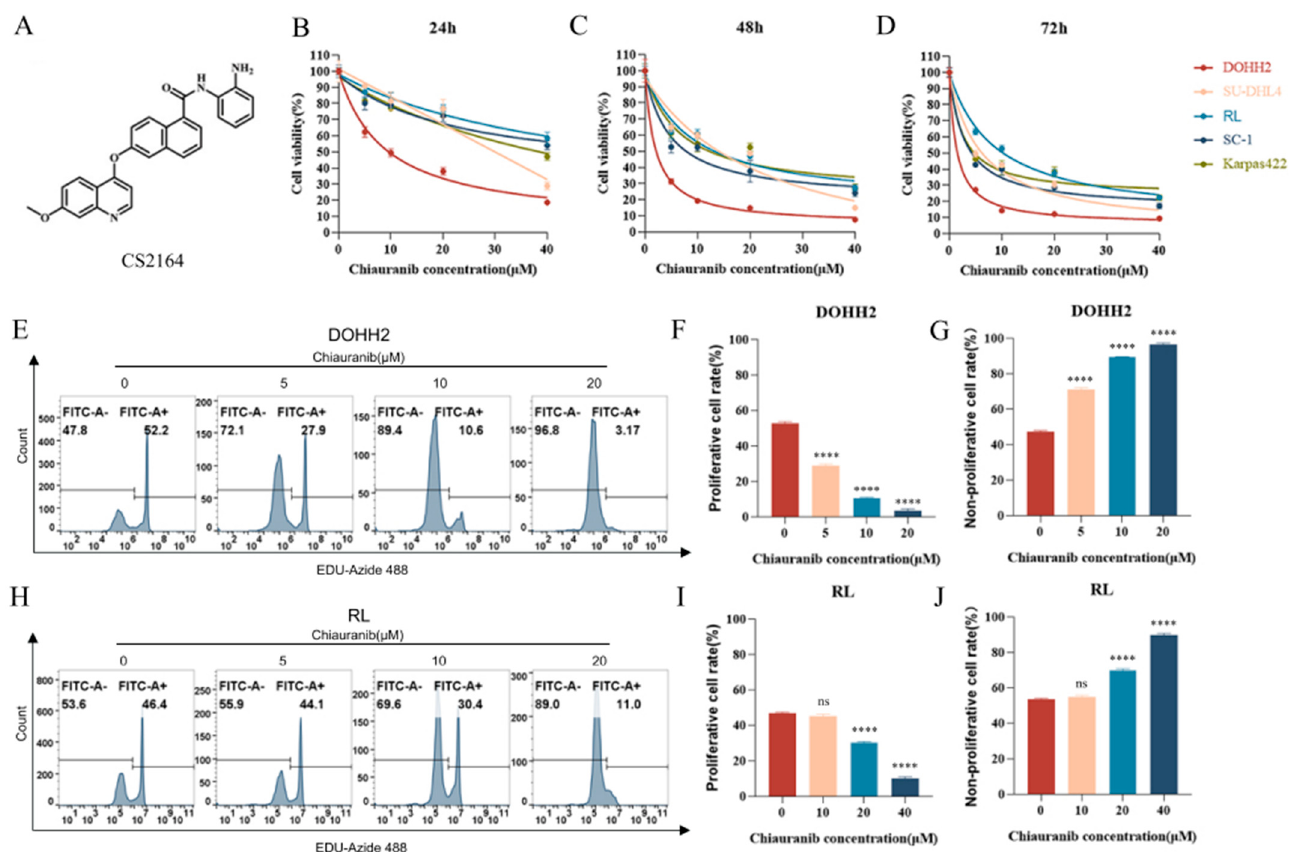
Figure 1. Chiauranib inhibited the proliferation of t-FL cells. ( A ) Chemical structure of the chiau- ranib. CS2164: N-(2-aminophenyl)-6-[(7-methoxy-4-quinolinyl)oxy]-1-naphthalene-carborxamide; Cell viability of t-FL cell lines including DOHH2, SU-DHL4, RL, SC-1, and Karpas422 tested by CCK8 assays after treatment with DMSO or chiauranib for ( B ) 24 h, ( C ) 48 h, or ( D ) 72 h. The results of EdU assays of ( E ) DOHH2 and ( H ) RL. Data from at least three independent experiments are shown in ( F , G ) DOHH2 and ( I , J ) RL (**** p < 0.0001).